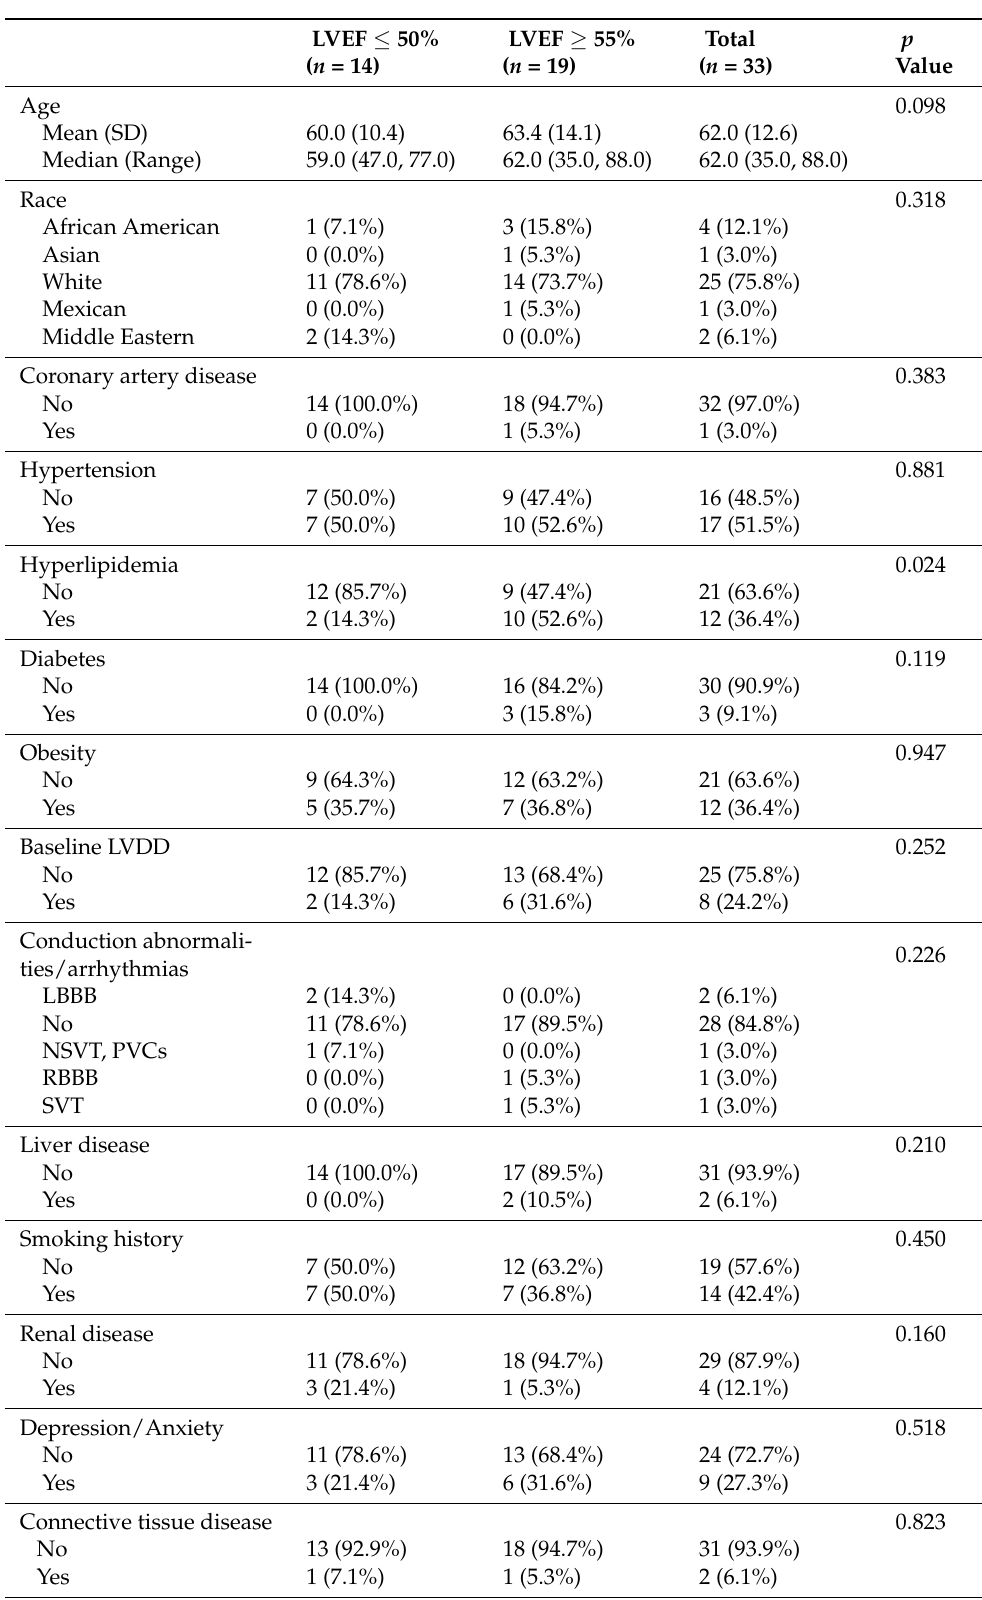
Table 1. Baseline characteristics of patients without cardiotoxicity compared to those developing CIC (defined as LVEF ≤ 50% following chemotherapy